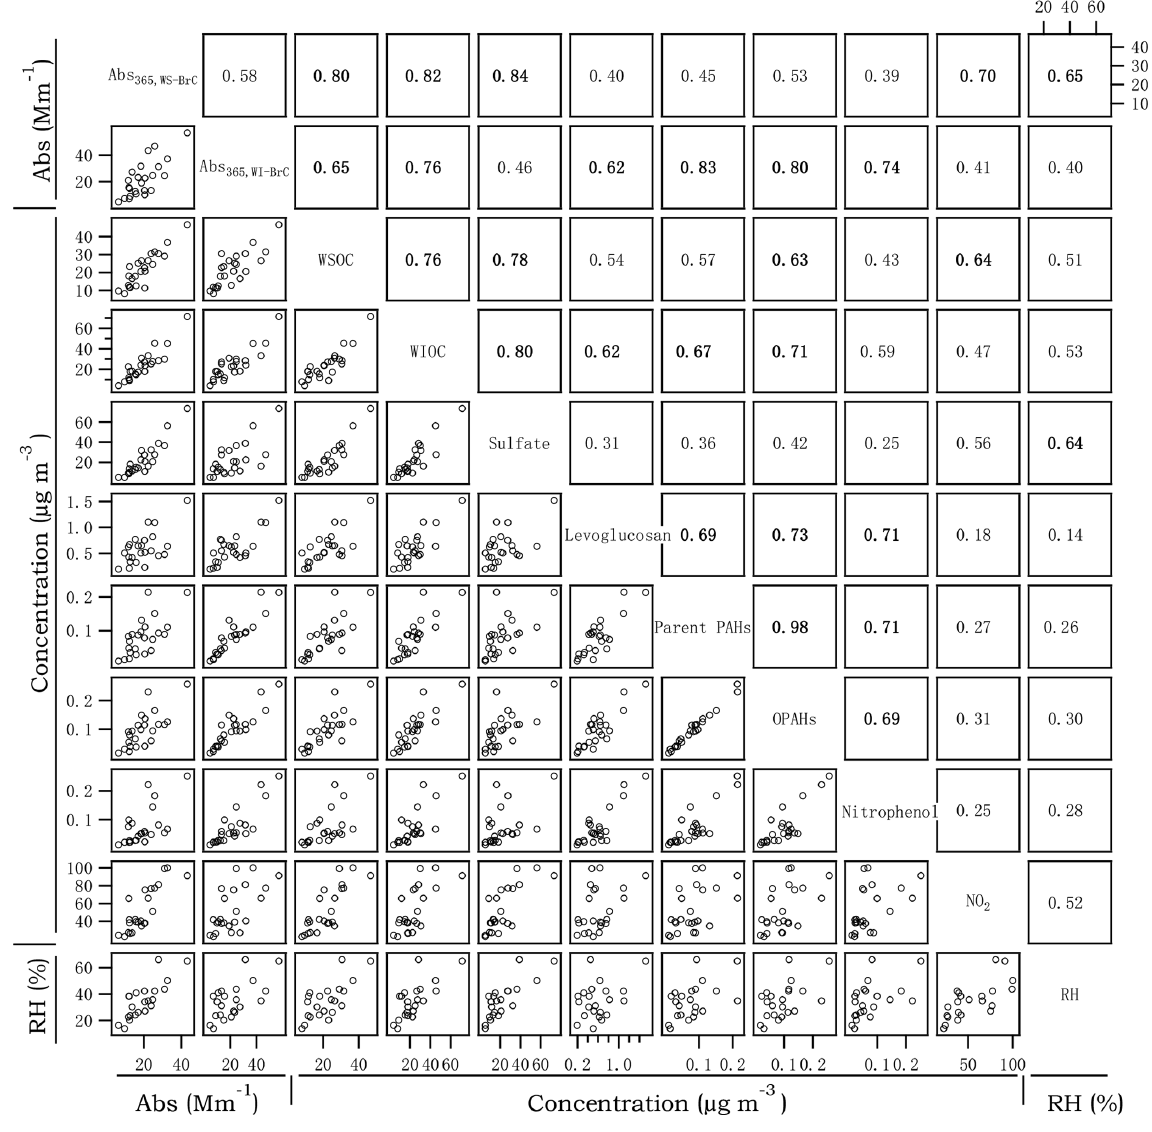
Figure 4. Cross correlations between Abs 365 , WS-BrC , Abs 365 , WI-BrC , selected chemical compositions and RH in winter. The numbers at the upper right denote the linear correlation coefficients ( r 2 ) of the corresponding scatter